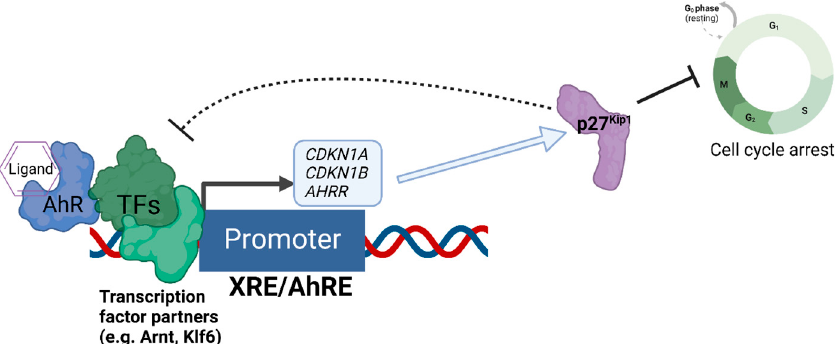
Figure 2. Negative regulation of AhR-mediated transcription by the expression of p27 Kip1 . The diagram depicts the regulatory relationship between p27 Kip1 and AhR, whereby AhR acts as a direct transcriptional regulator of the transcription of p27 Kip1 , and increased expression of p27 Kip1 both inhibits cell cycle progression and represses the AhR-mediated transcription of genes such as CDKN1A (encoding p21Cip1), AHRR , and CDKN1B (encoding p27 Kip 1 itself) as an auto-feedback